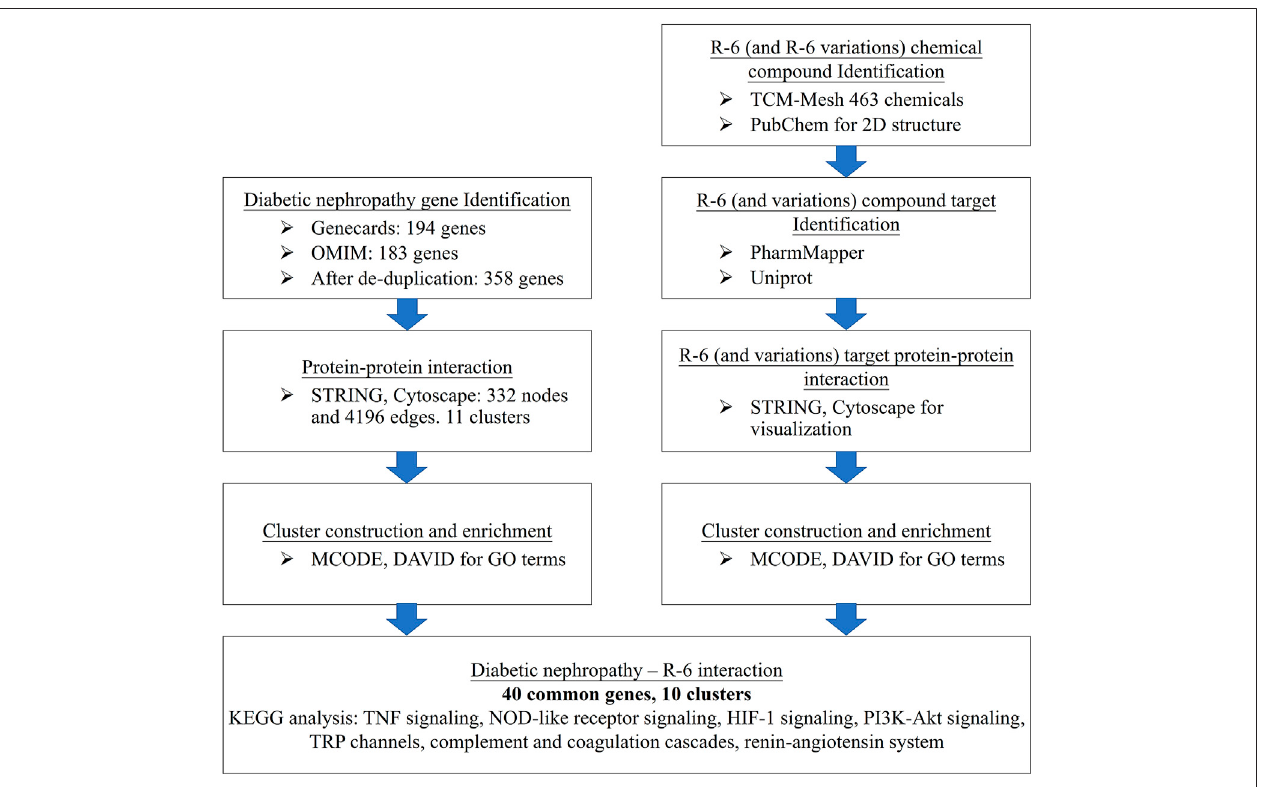
FIGURE 1 | Computational work fl ow of disease – drug network analysis. Disease-related genes were retrieved from GeneCards and OMIM. The chemical compound IDs of each herb were retrieved from TCM-Mesh and PubChem. Drug targets were revealed via PharmaMapper and UniProtKB. The disease gene interactions were assessed through STRING, and the disease – drug protein – protein interaction network was integrated and visualized by Cytoscape. Functional annotation of clusters was analyzed by DAVID and KEGG pathway enrichment.